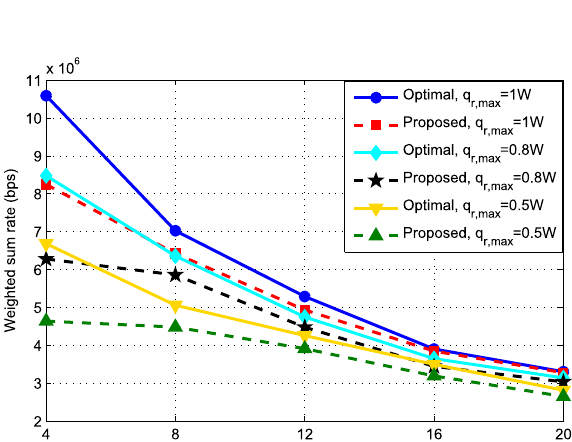
Fig. 3 Simulation topology